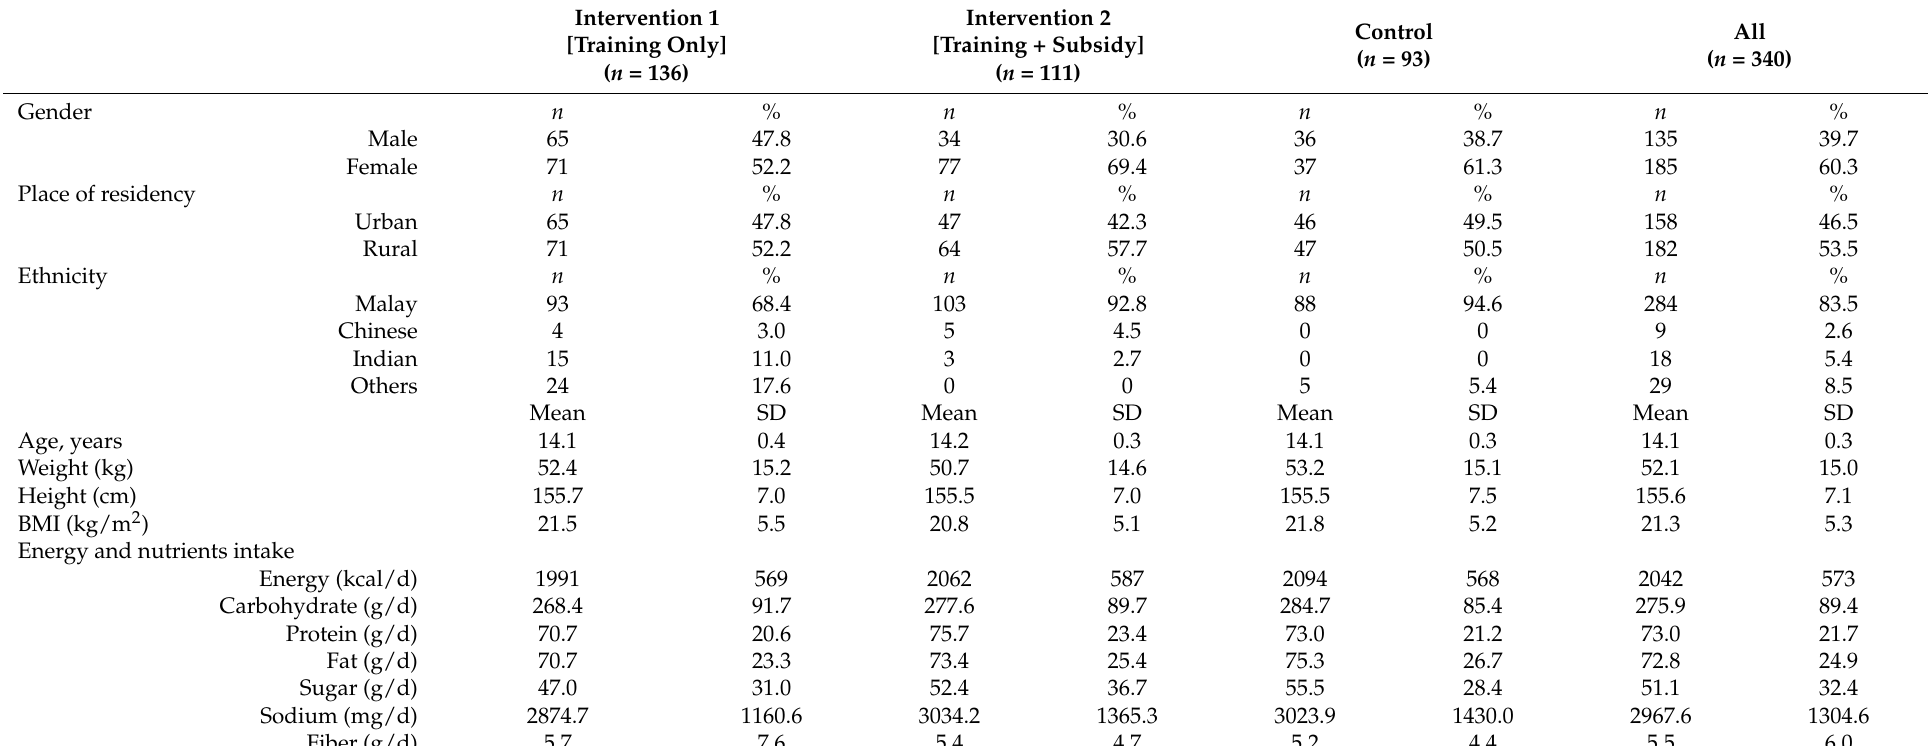
Table 1. Baseline demographic, anthropometry and dietary intake of MyHeARTBeAT respondents (mean [SD] or frequencies